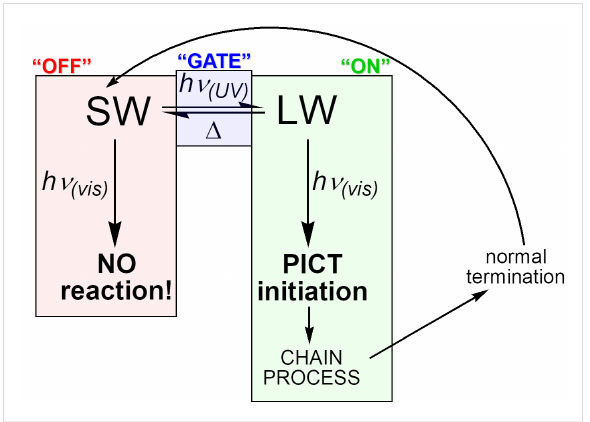
Figure 1: Proposed gating of sensitivity to photoinduced charge transfer by a photochromic photooxidant in which only LW is a compe- tent photooxidant of the donor of